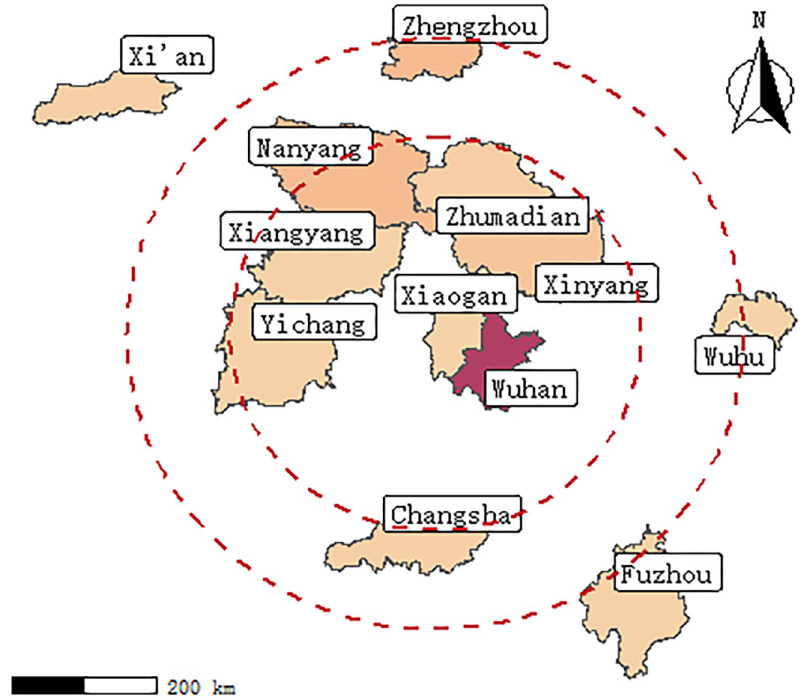
Fig 1. Range of research subjects selected for the current